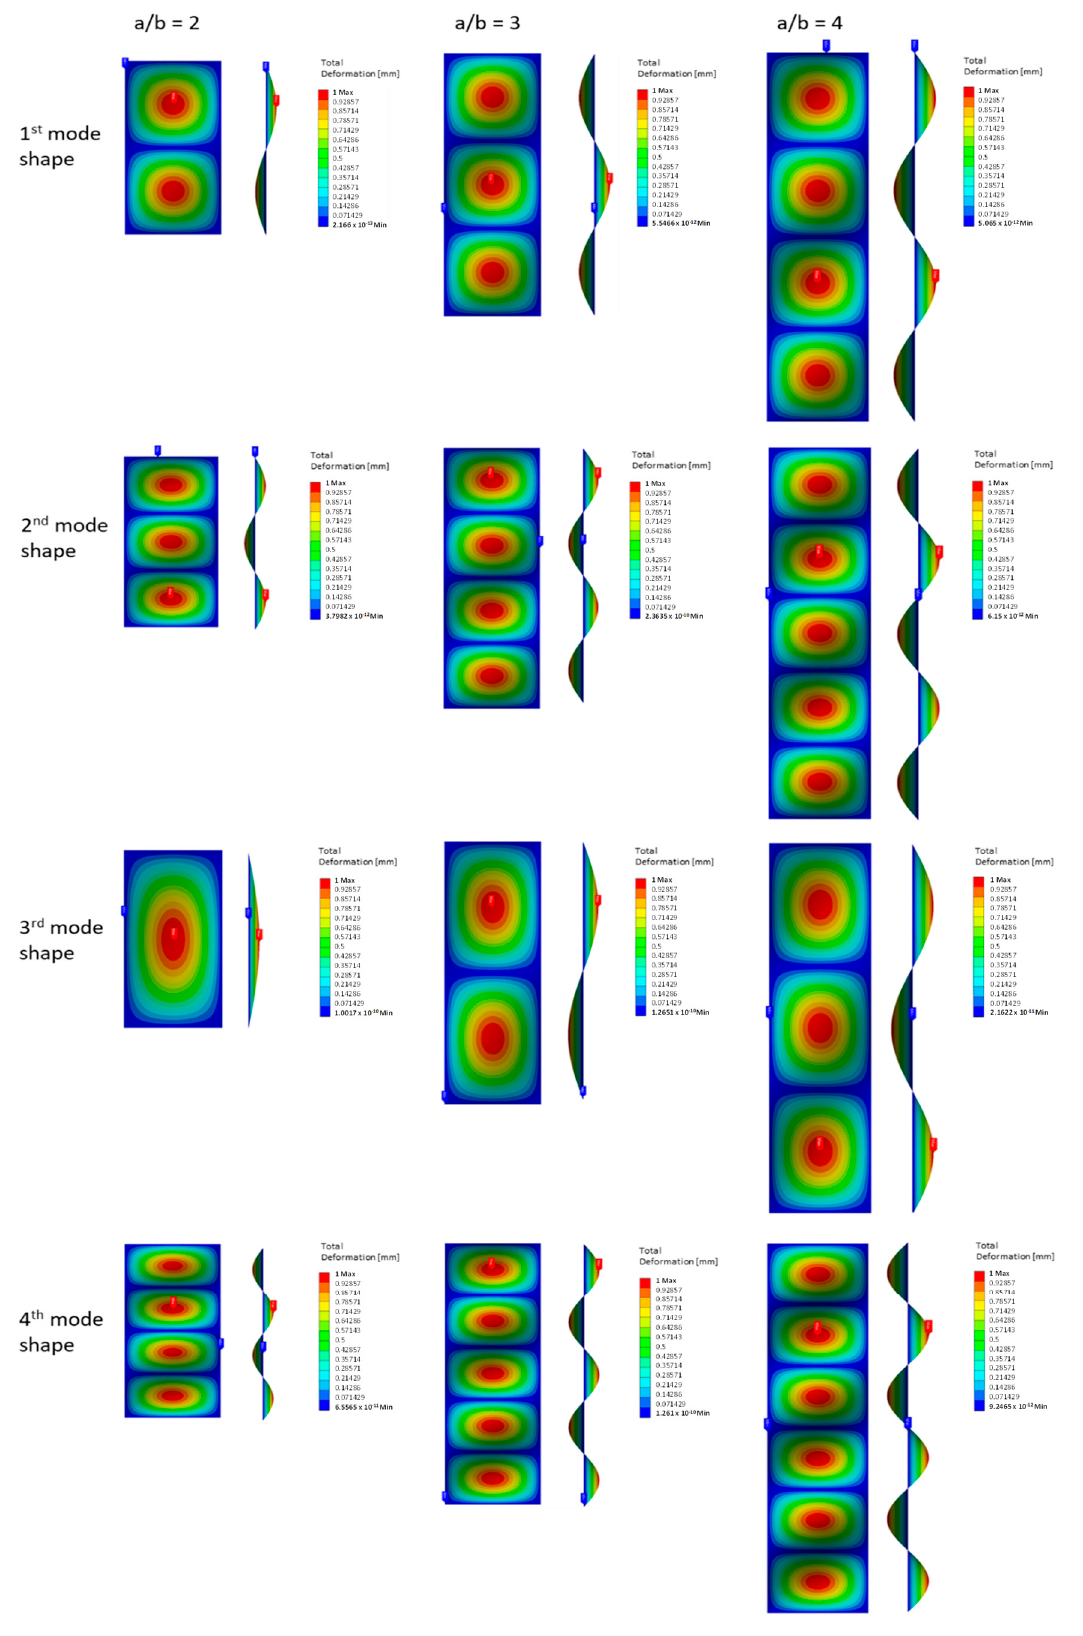
Figure 16. First four mode shapes in the 2, 3, and 4 aspect ratio a / b and 3 mm thickness of the plate.